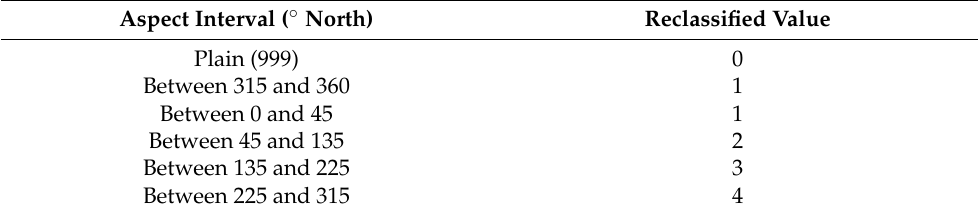
Table 3. Terrain aspect